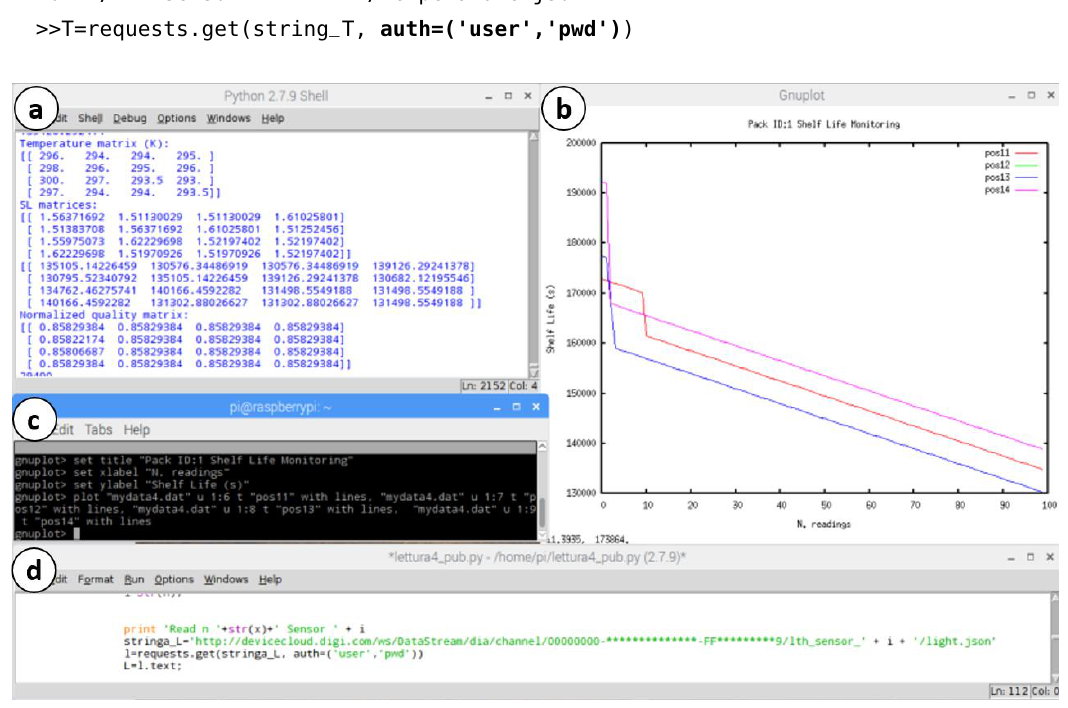
Figure 10. Screenshot of RPi-based Central Control Unit display: ( a ) Numeric monitoring of SL, C, T, etc. ( b ) Chart of SL monitoring of the selected positions for a specific pallet ( c ) Chart settings panel ( d ) HTTP-request panel for cloud reading. ( d ) HTTP-request panel for cloud